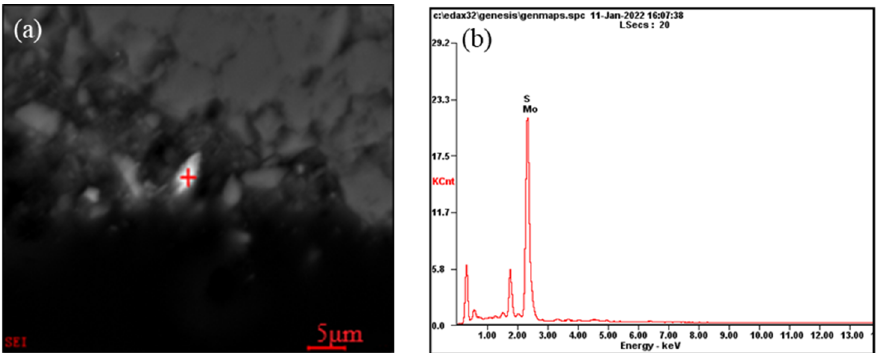
Figure 8. Molybdenite occurrence in the ore: ( a ) Scanning electron microscope image of molybdenite in stone coal; ( b ) EDS analysis for the molybdenite at “+” position.